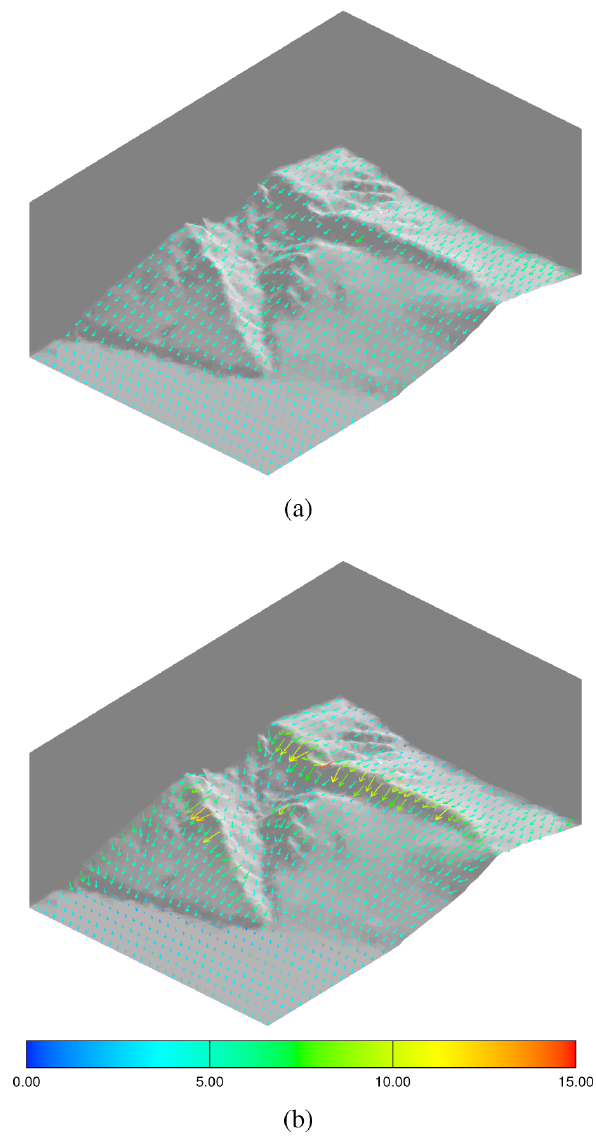
Figure 1 : Interpolated (a) and resulting (b) wind field (m s − 1 ) at 20 m over the terrain.